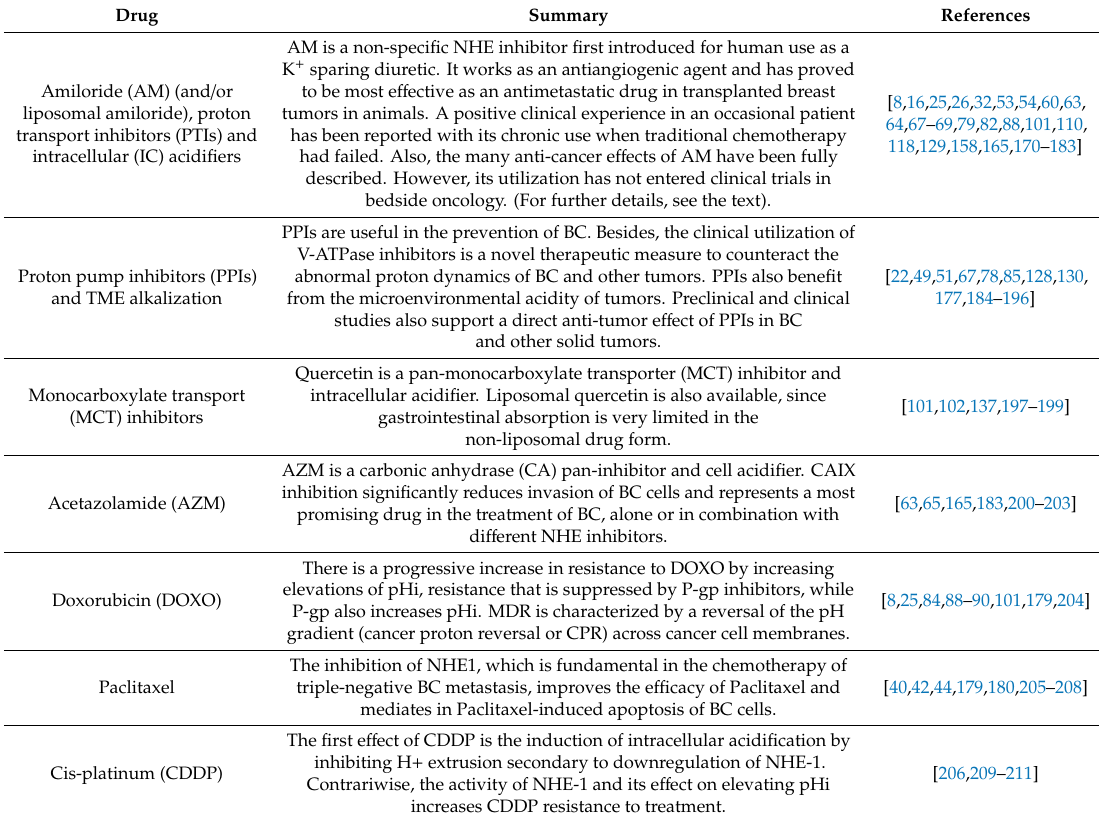
Table 2. pH-related drugs with present and potential benefit in the treatment of breast cancer. BC: Breast cancer; NHE: Na + / H + antiporter; MDR: Multiple drug resistance; P-gp: P-glycoprotein; CAs: Carbonic anhydrases; ER + : Estrogen positive cells; ER-: Estrogen negative cells; PTIs: Proton transport inhibitors; PPIs; Proton pump inhibitors. TME: tumor